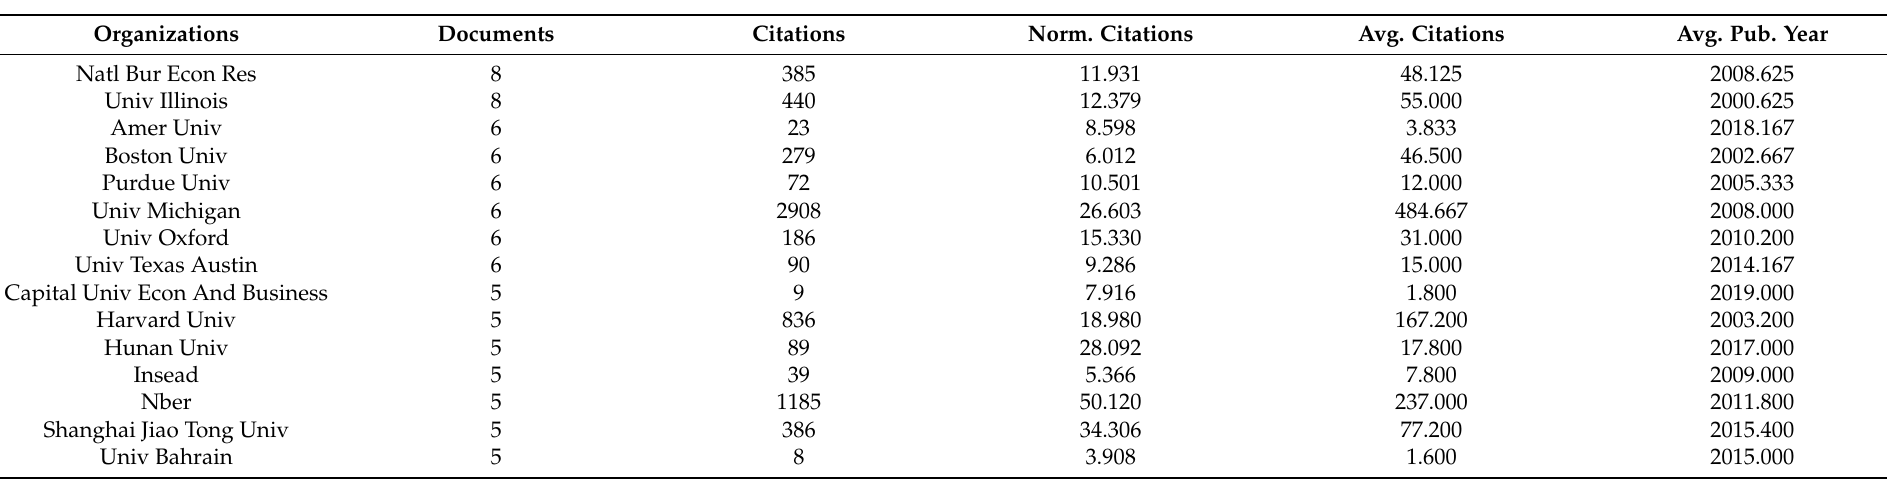
Table 5. Co-authorship links and top 15 (documents) organizations items, considering 1 as the minimum number of documents of an